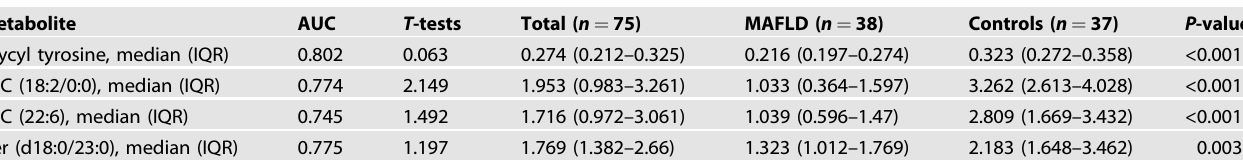
Table 2. Metabolic biomarkers in predicting